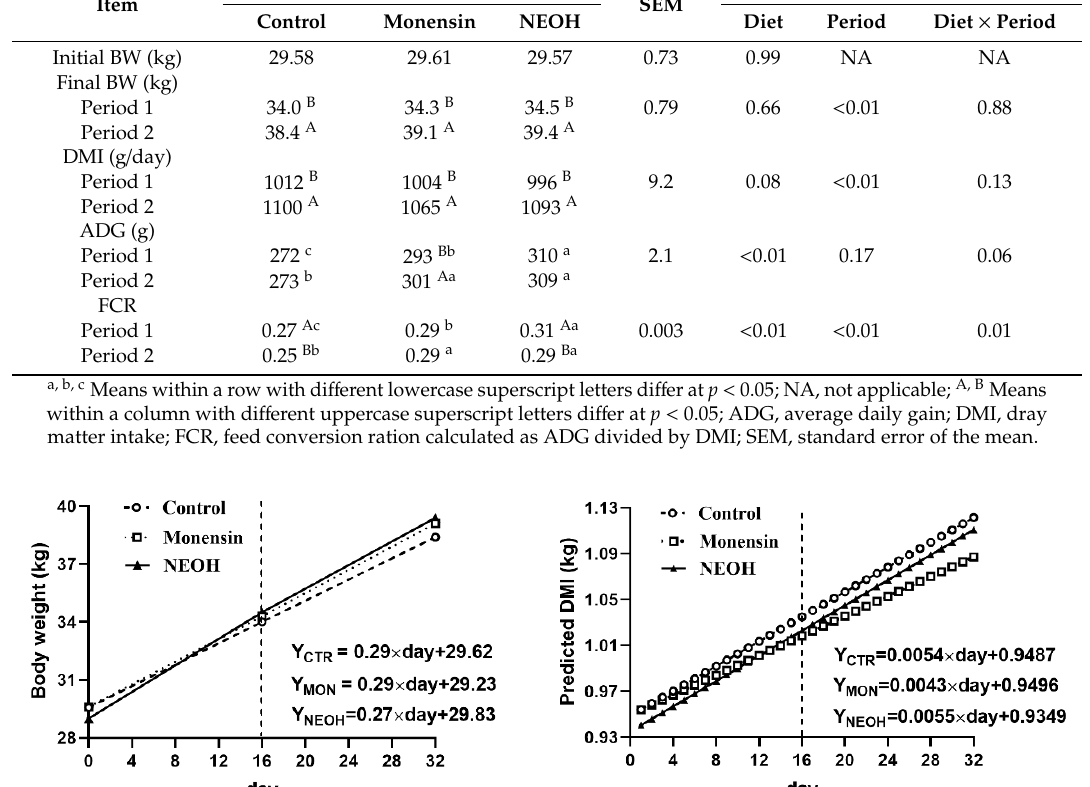
Table 3. Supplementation effects of monensin and nitroethanol (NEOH) to lamb diet in feeding period 1 (day 0 – 16) and their withdrawn effects in subsequent period 2 (day 17 – 32) on live body weight (BW), dry matter intake (DMI) and growth performance.